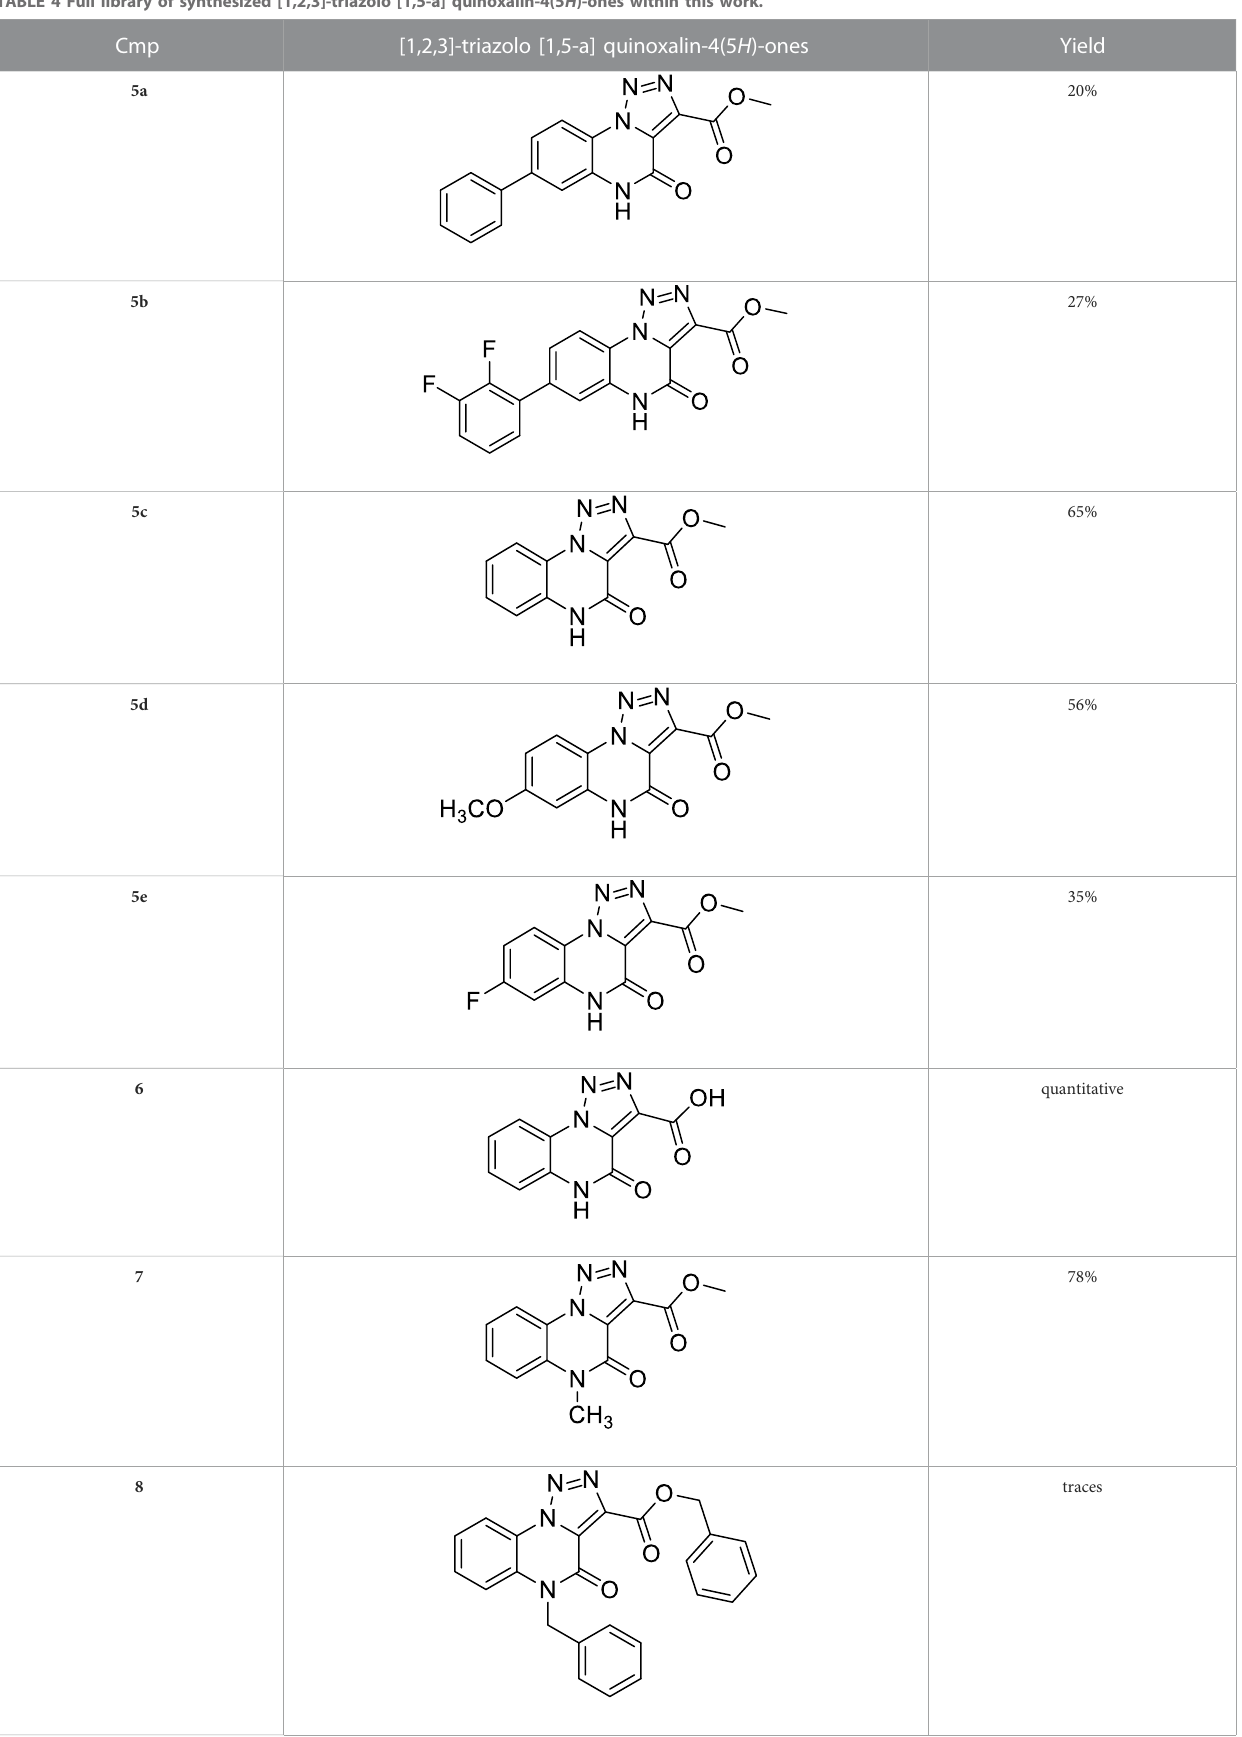
TABLE 4 Full library of synthesized [1,2,3]-triazolo [1,5-a] quinoxalin-4(5 H )-ones within this